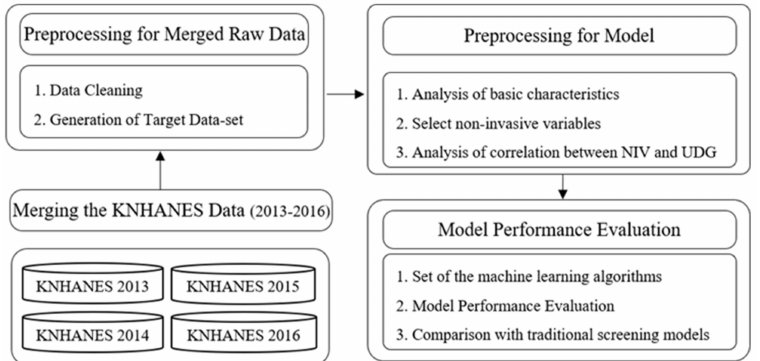
Figure 1. Research framework of the DLM (deep learning model) for patients with undiagnosed diabetes. NIV: non-invasive variables; UDG: undiagnosed diabetes group; KNHANES: korean national health and nutrition examination